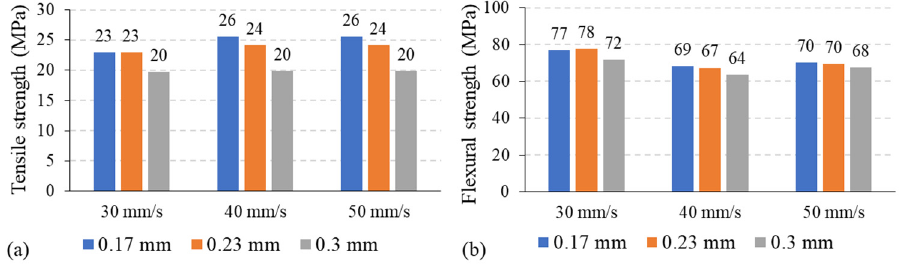
Figure 17. PETG ( a ) tensile and ( b ) flexural strength sensitivity to various layer thicknesses with different printing speeds (in mm/s).